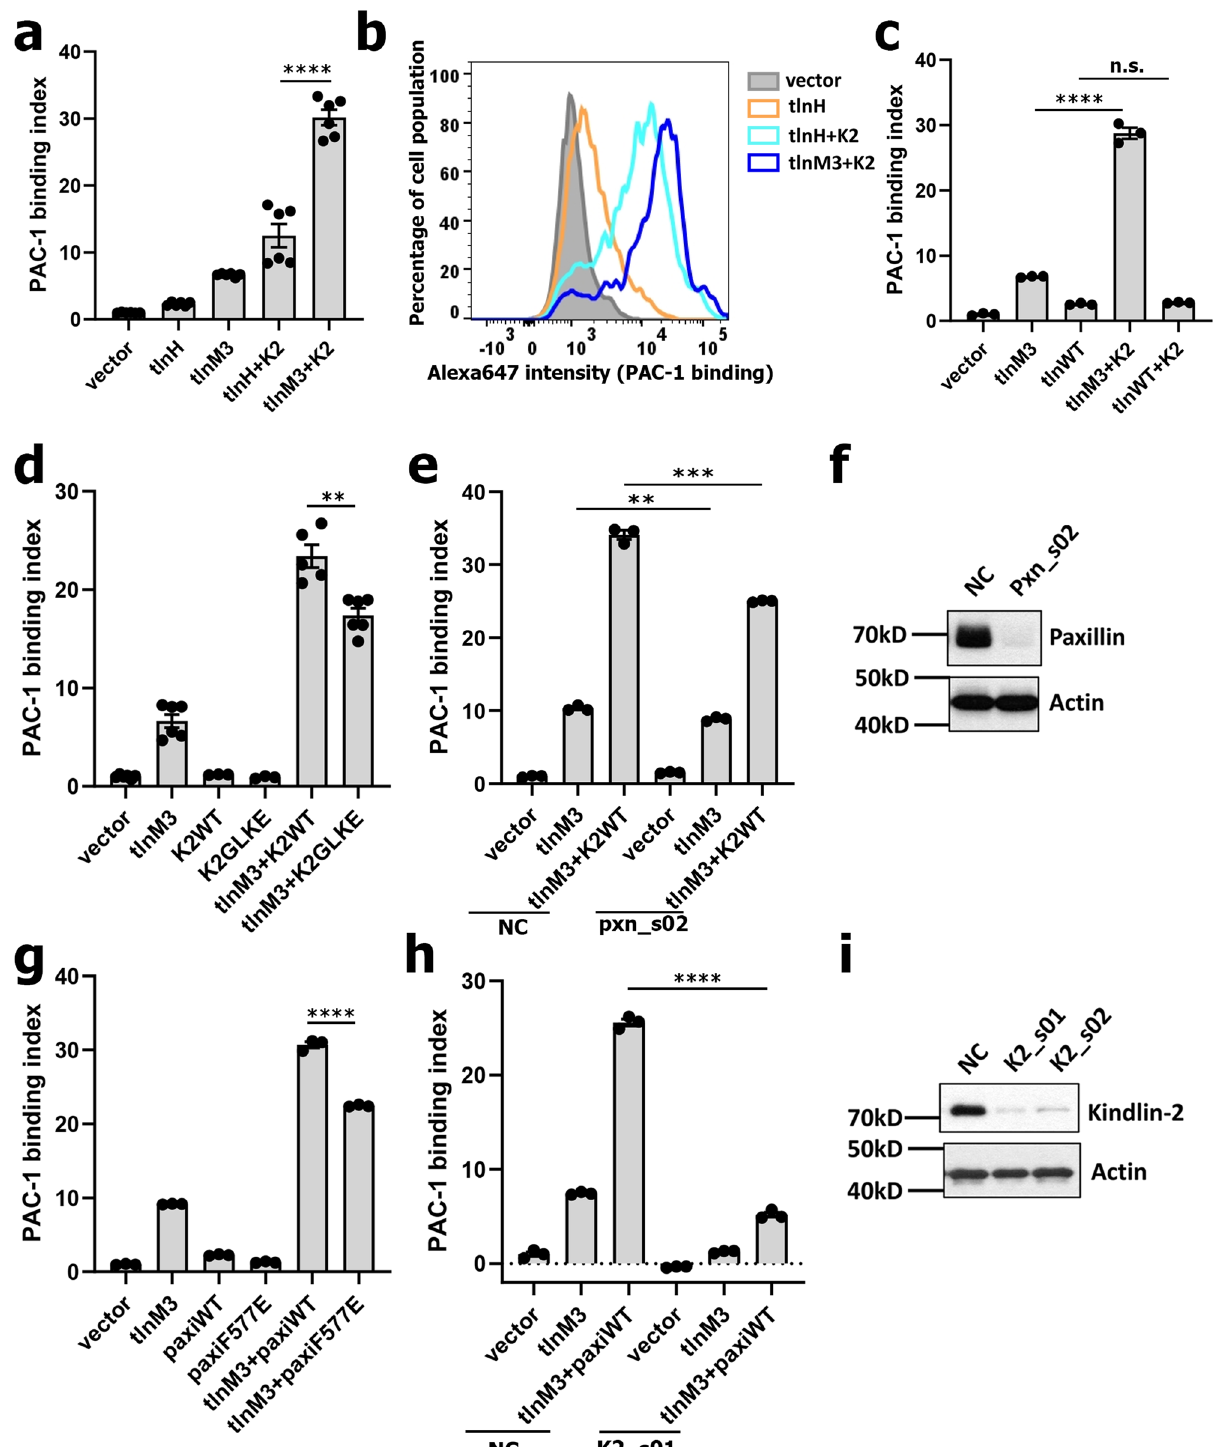
almost negligible chemical shift changes by paxillin (Supplemen- (Supplementary Fig. 7c), and to F3 at K D ~ 3.51 μ M (Supplemen- tary Fig. 6e). In talin-H, only talin-F3 exhibited chemical shift tary Fig. 7d). As expected from the pull-down data (Supplemen- changes upon addition of paxillin 1 – 160 (Supplementary Fig. 6f). tary Figs. 5b and 5d), talinR1 – R4 as the dominant paxillin- Table S1 provides the summary of the HSQC-based binding binding core exhibited strong af fi nity to paxillin 1 – 160 at results for all talin subdomains. Quantitative SPR experiments on K D ~ 153 nM (Supplementary Fig. 7e). It is important to note that talin-R1 – R4 binding to paxillin 1 – 160 fi ts very well in 1:1 those subdomains that showed signi fi cant chemical shift changes ratio by two-state model, suggesting that talin-R2, as the main by paxillin 1 – 160 revealed that paxillin 1 – 160 binds talin-R2 at binding module, may cooperate with R3 or R4 to bind paxillin via K D ~ 2.21 μ M (Supplementary Fig. 7a), to talin-R8 at K D ~ 5.37 μ M (Supplementary Fig. 7b), to R11 at K μ M a multisite binding mode. As a comparison, talin-F3, D ~ 12.7